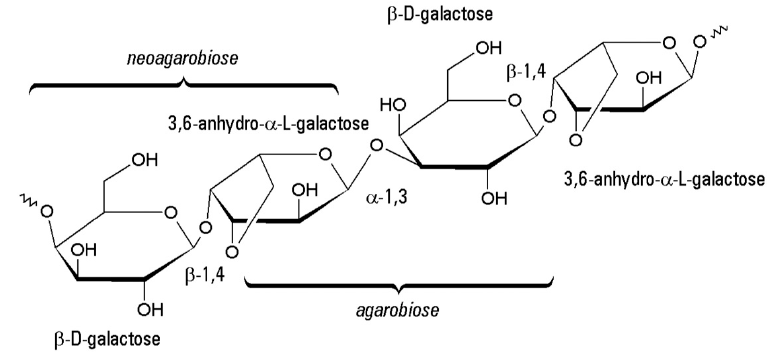
Figure 7. Molecular structure of agarose.